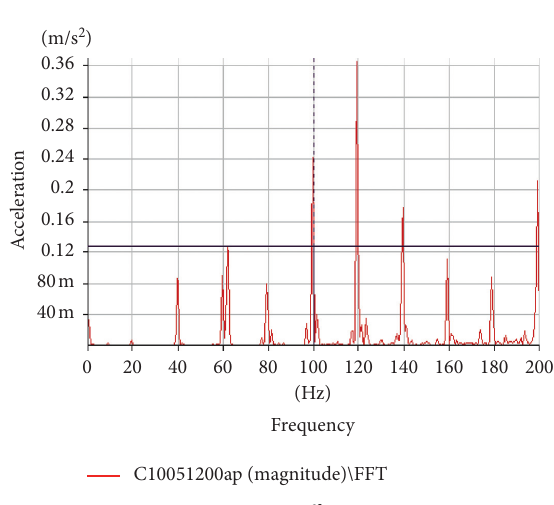
Figure 4: 0.08mm offset, 1200rpm.